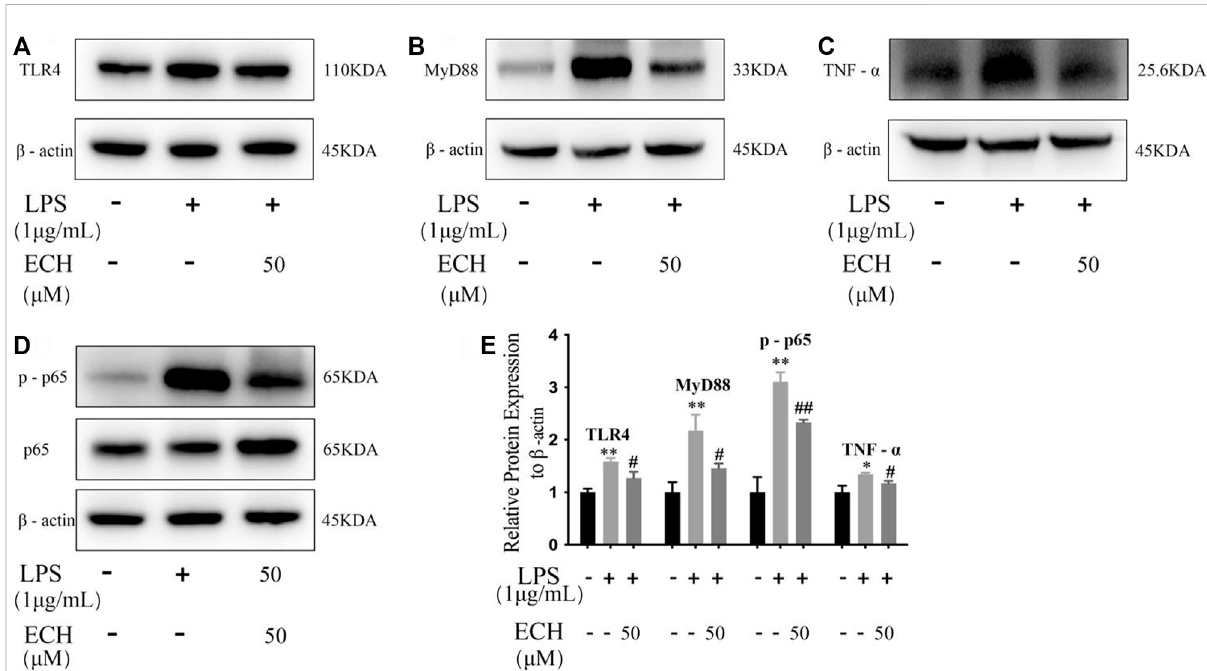
FIGURE 11 In fl uence of ECH on in fl ammatory response during the TLR4/NF- κ B signaling pathway in L02 cells. (A) Protein expressions of TLR4. (B) Protein expressions of MyD88. (C) Protein expressions of TNF- α . (D) Protein expressions of p-P65; (E) Protein expression levels of TLR4, MyD88, p-65, and TNF- α the control group compared with theLPS group * p < 0.05 and ** p < 0.01; ECH group compared with the LPS group # p < 0.05 and ## p < 0.01; all data are presented as mean ± SD ( n =